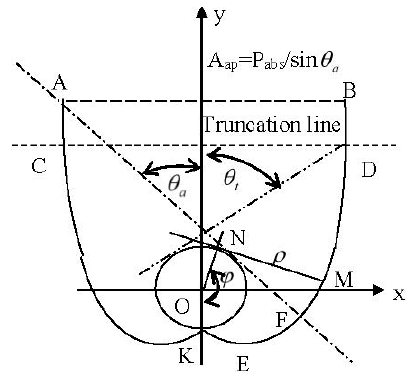
Figure 1. Geometry of a tubular absorber ideal solar concentrator (not to scale).